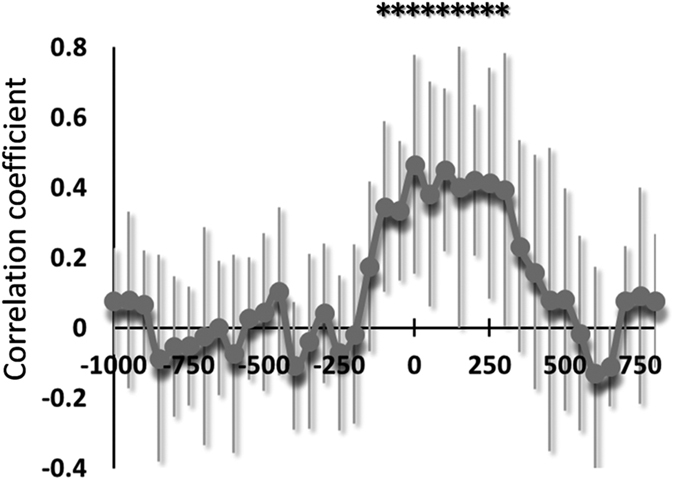
Spatial correlation of decoding accuracies between real and imagined movements averaged over subjects.Significant spatial correlations were observed around response onset (Pearson’s test, *p < 0.05) (error bar, SD).